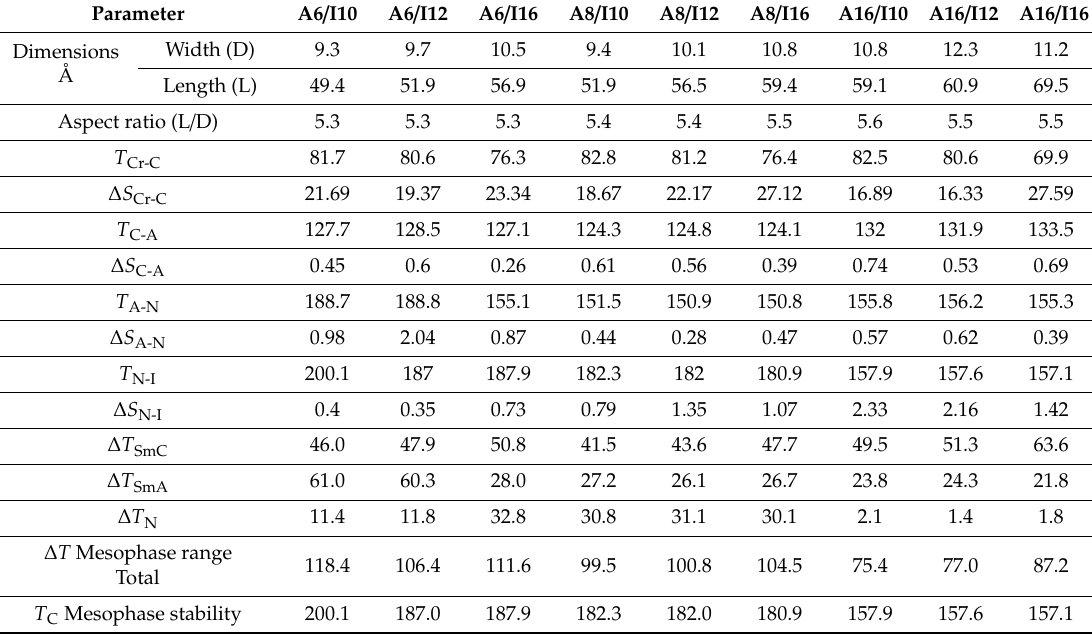
Table 2. Dimensional parameters, aspect ratios and mesophases range of SMHBCs An / Im.